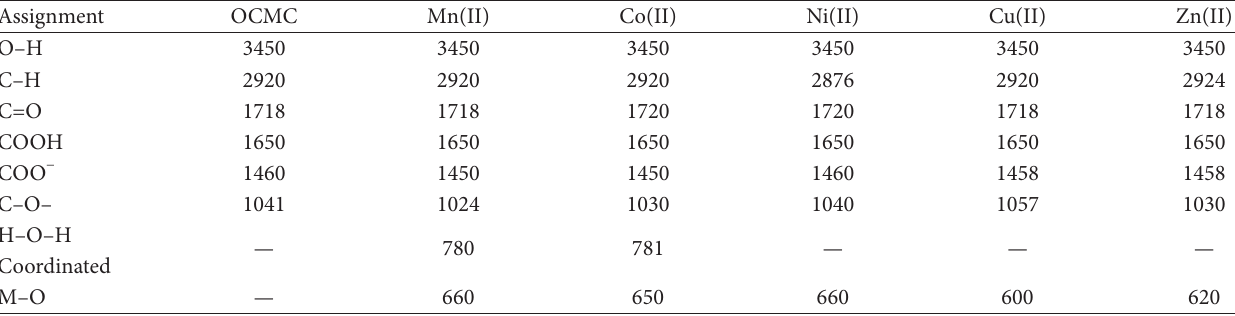
T 2: IR spectral assignments of OCMC ligand and its Metallic Gel complexes.